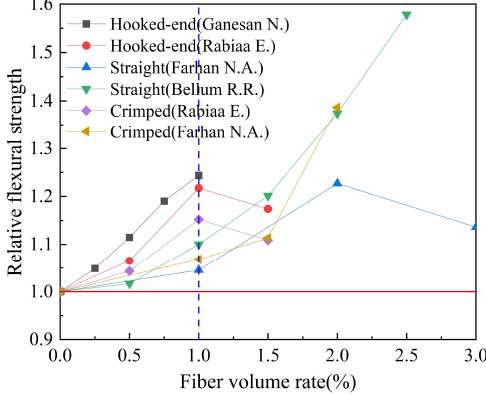
Figure 22. The effect of fiber shape on flexural